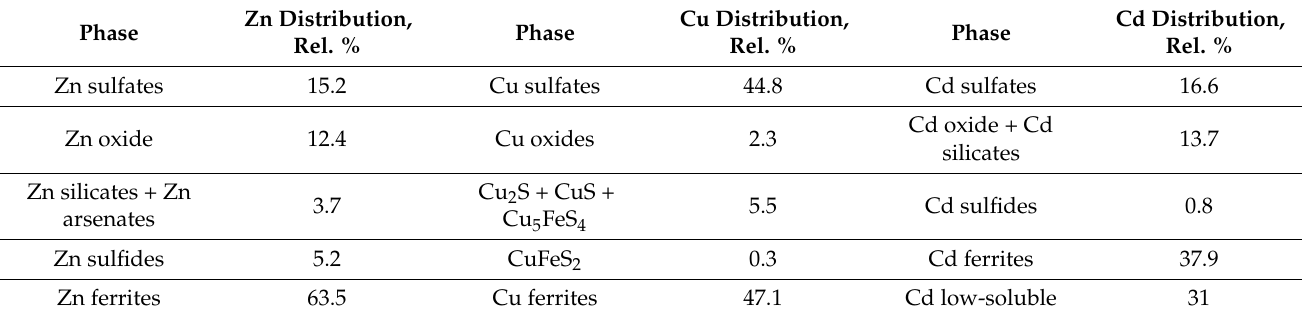
Table 3. Phase composition of zinc, copper and cadmium minerals in the ZPR sample.